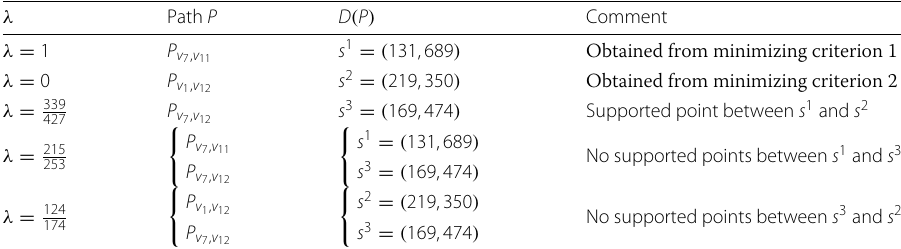
Table 2 Example solutions computed by Phase